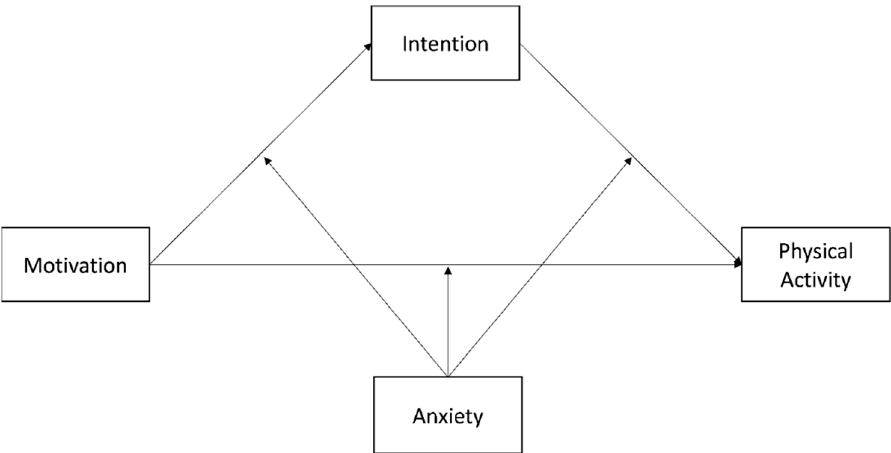
Figure 1. Graphic of the hypothesized moderated mediation model.